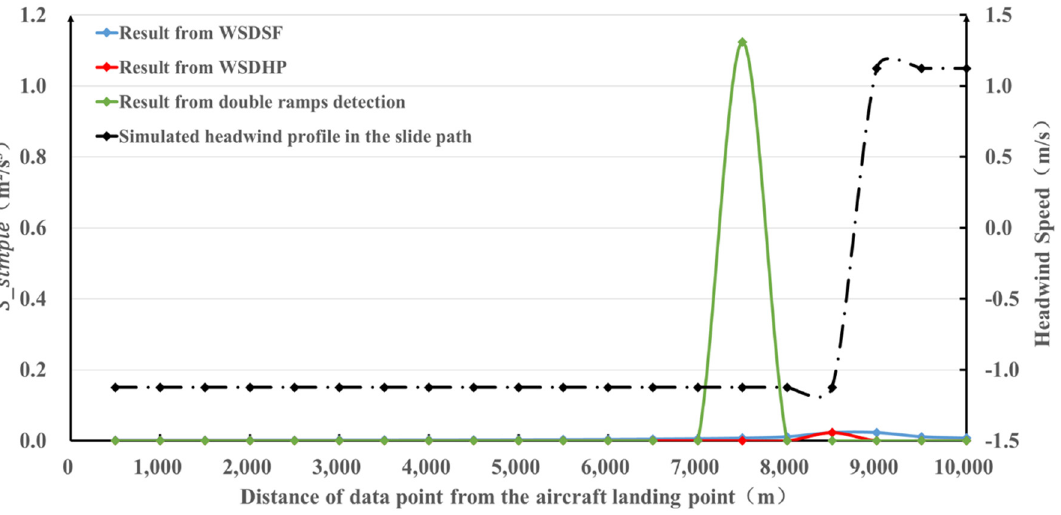
Figure 7. The results of wind shear detection under the background of the frontal wind field.